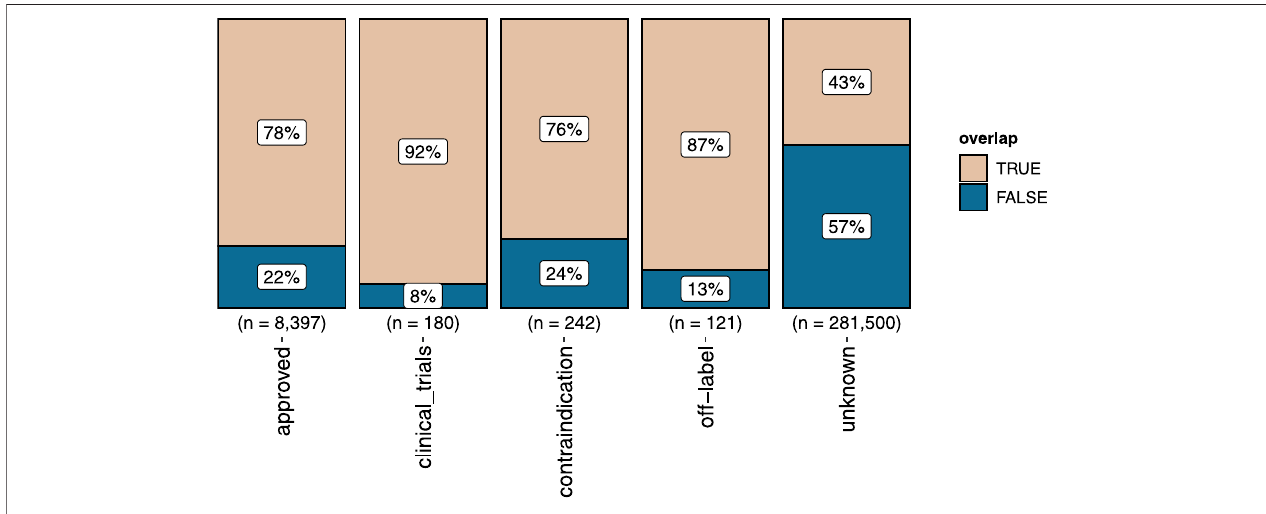
FIGURE 2 | The proportion of gene overlap (marked “ TRUE ” ) between drug targets and disease genes in the different sets of positive and negative drug – disease combinations. The proportion of not overlapping genes is marked “ FALSE ” .